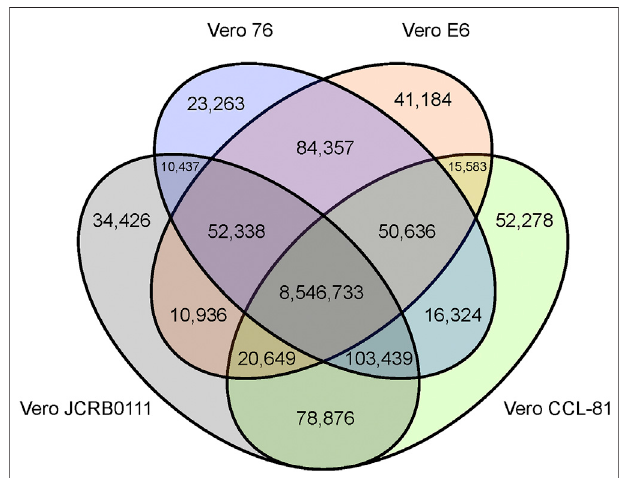
FIGURE2| Venndiagram ofSNVssharedamongthe fourdifferentVero sublines. The SNVs were identi fi ed using the AGM reference genome and SNVs with frequency ≥ 0.2 were